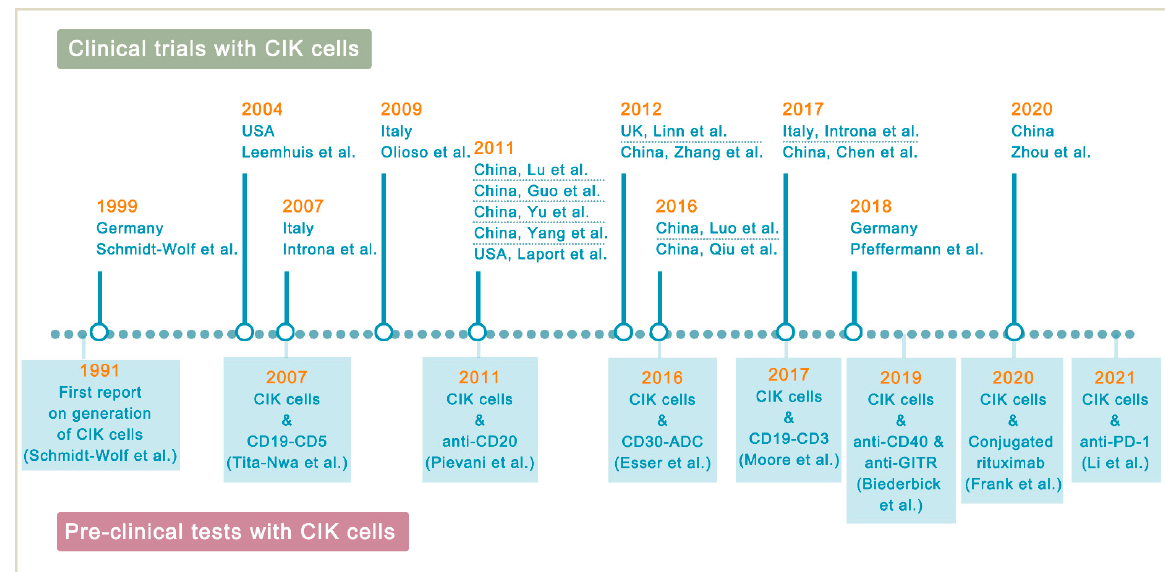
Figure 2. Highlights in the development of CIK cell immunotherapy. In 1991, the development of CIK therapy began (in Germany) and continued in several countries, with 2011 being the year with the most clinical trial reports. The supporting pre-clinical models that are used to improve the therapeutic activity of CIK cells are also highlighted.